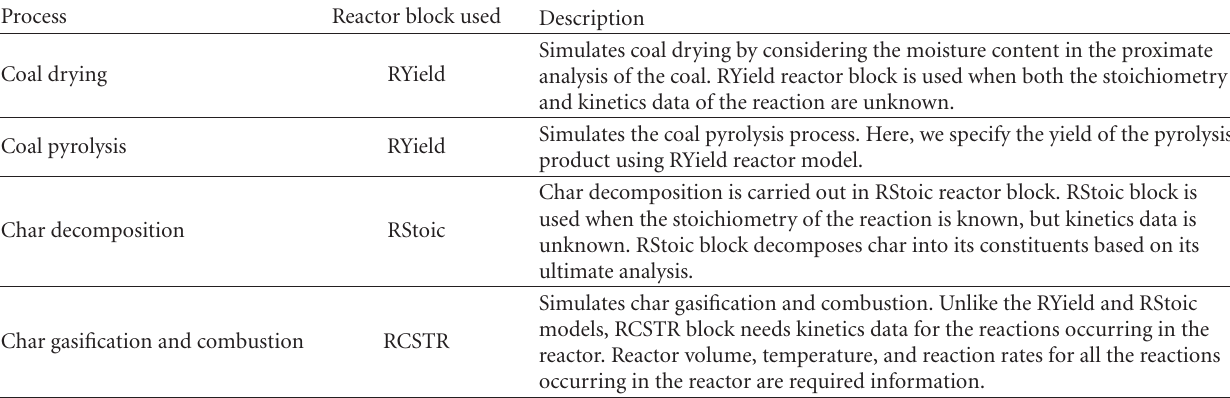
Table 2: Descriptions of the various reactor blocks used in the model.